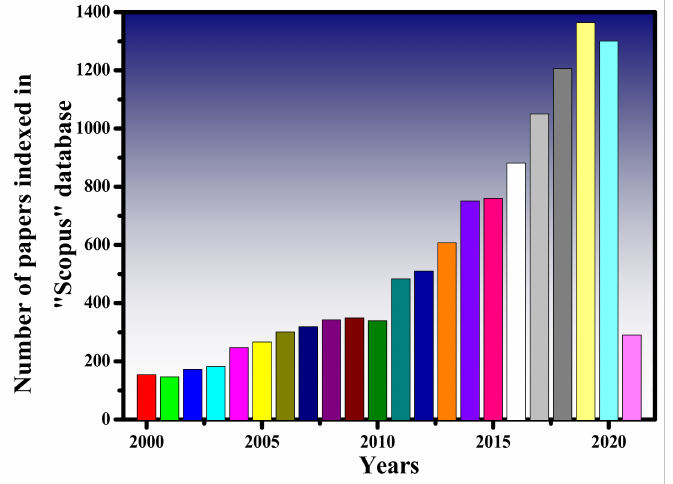
Figure 1. The number of papers related to the “Orbital angular momentum” topic searched in the Scopus database for the years